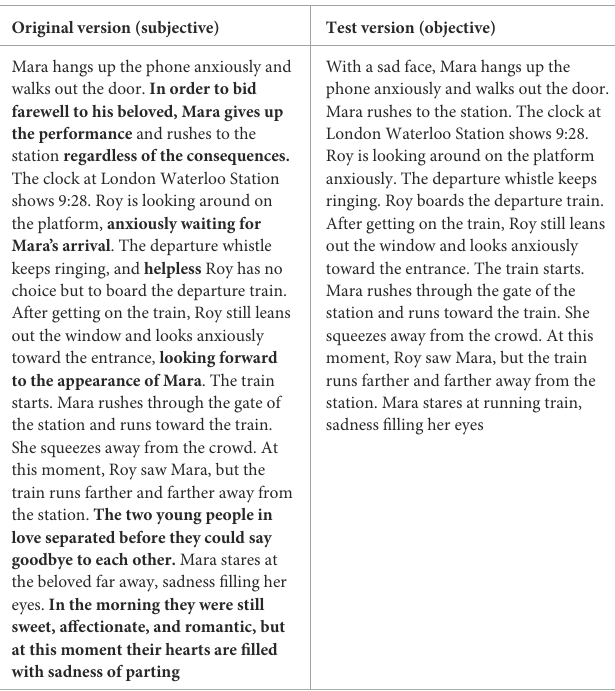
TABLE 1 Subjective vs. objective description clips from Waterloo Bridge . Context: On the night before the wedding of Mara and Roy, when Mara was preparing to go to the theater to perform, she received a call from Roy saying that the army order had been changed and he had to go to Waterloo station to set off